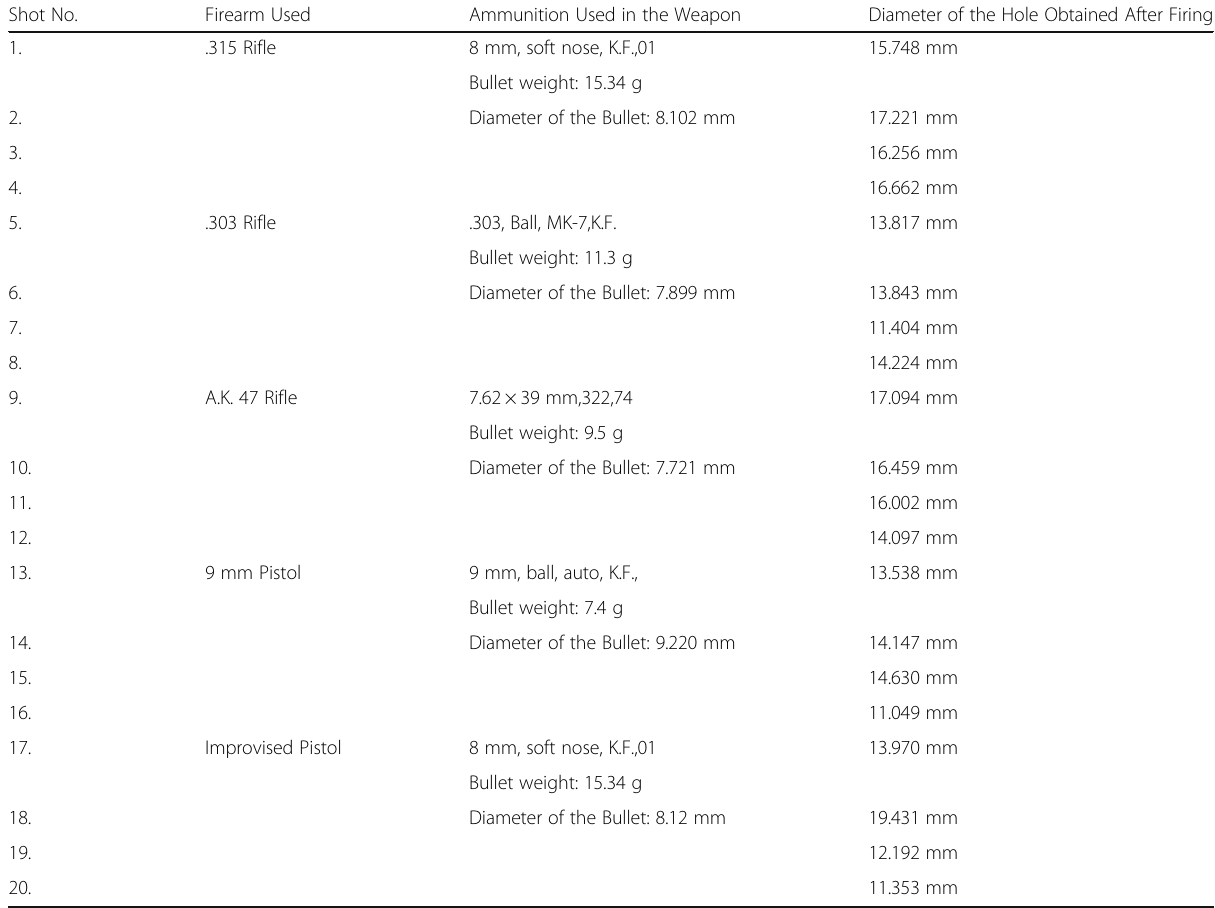
Table 5 Data of Hole Diameter Made by Different Ammunition Shot No. Firearm